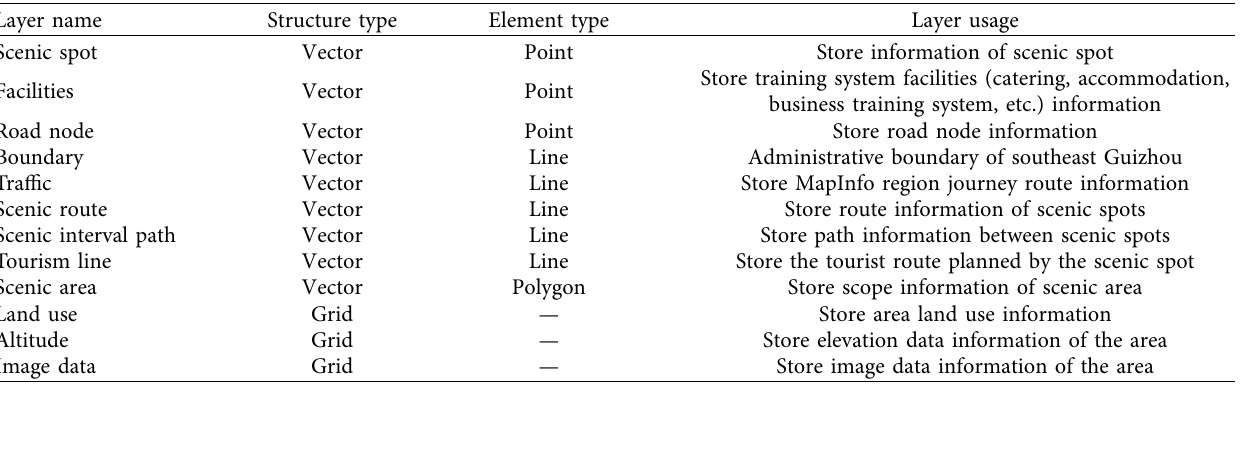
Table 1: Spatial data layer.